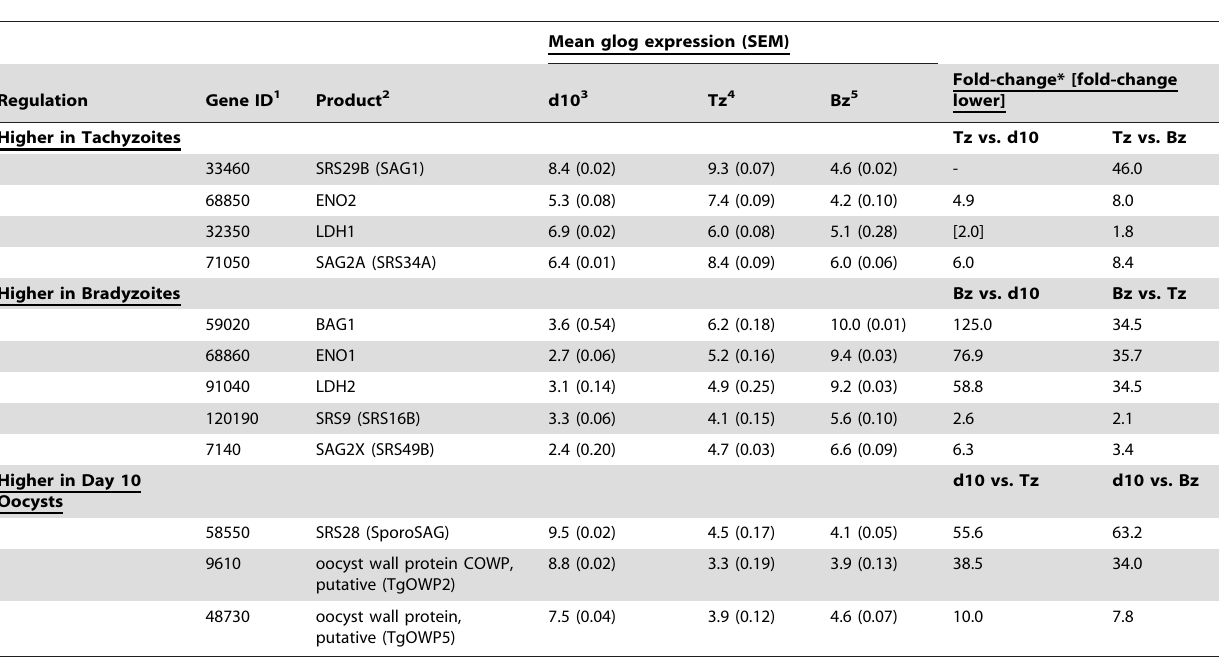
Table 1. Validation of gene expression comparing known developmentally-regulated Toxoplasma gondii genes.